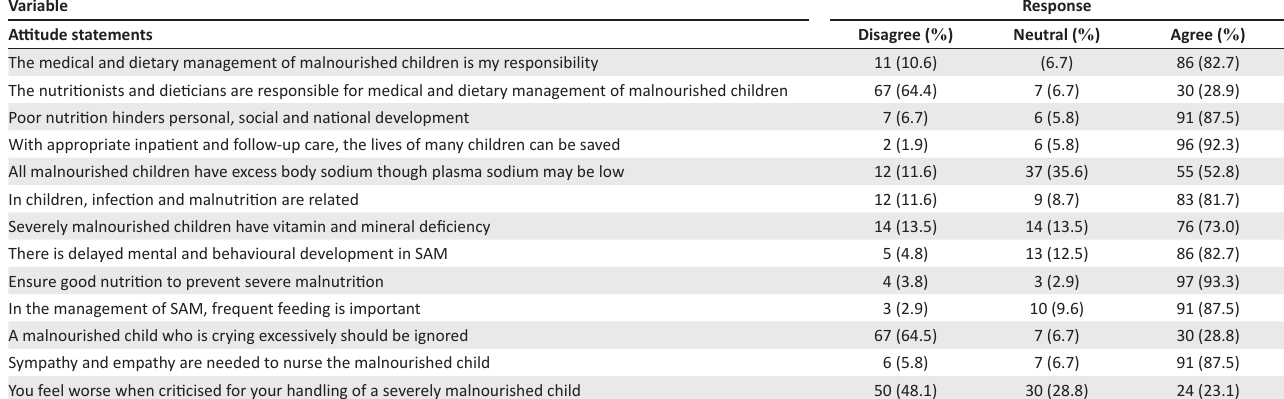
TABLE 4: Nurses’ attitudes towards malnutrition in children and its management. Variable